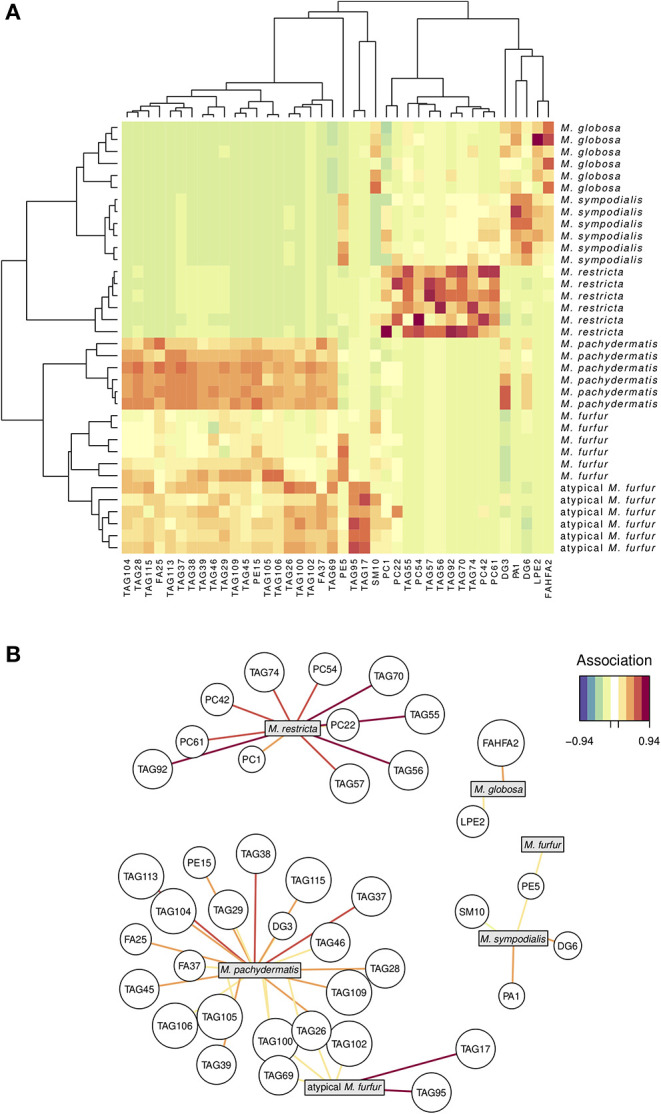
Lipidomic signature in five species of Malassezia and a putative M. furfur (atypical M. furfur) strain, six biological replicates were analyzed. A sparse least partial square analysis coupled to a discriminant analysis (sPLS-DA) reduced the dimensionality of 428 to 40 compounds, which successfully discriminated among the studied lineages. Above (A), both species and compound clustering according to the similarity in lipid profiles; the heat map denotes higher (red) to lower (green-blue) concentrations of each compound. Below (B), network visualization of the correlation between each species and the main compounds that characterize it; both positive and negative correlations with magnitude below 0.52 are not included for clarity. The color of the line denotes the magnitude of the correlation coefficient.